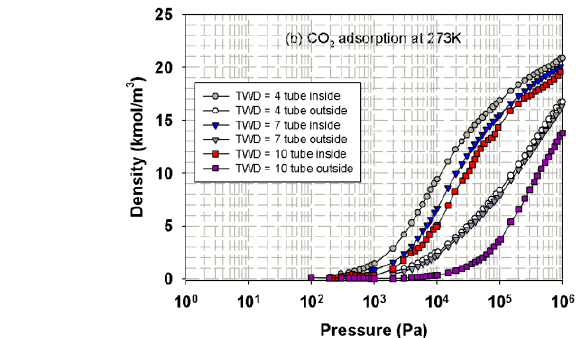
Figure 16. Adsorption isotherms of CH 4 ( a ) and CO 2 ( b ) in bundles of 16.3 Å tubes at 273 K at various tube wall distance of 4, 7 and 10 Å .